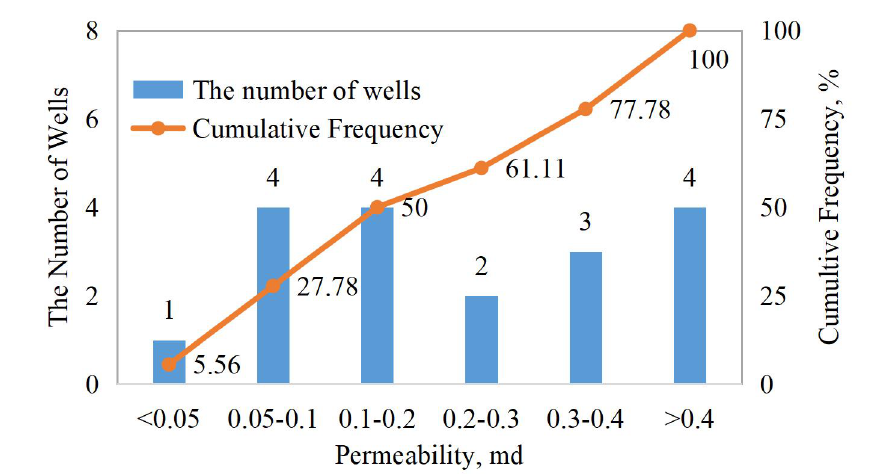
Figure 14—Cumulative frequency distribution of horizontal wells